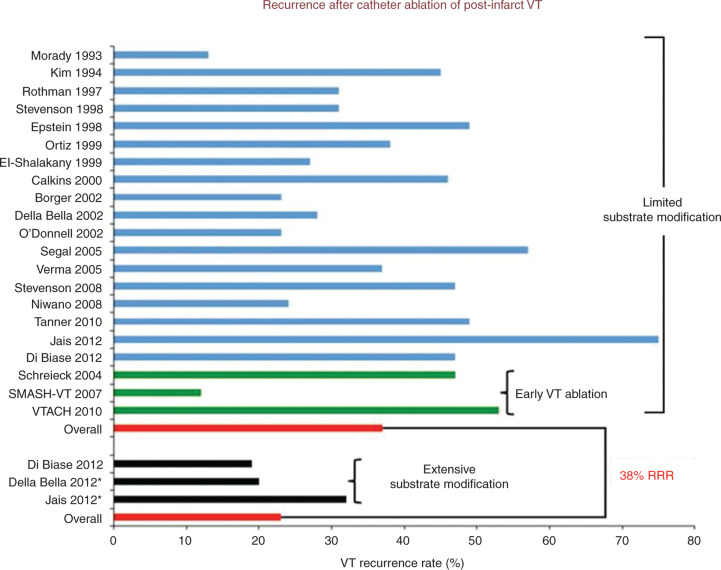
Recurrence of post-infarction VT after catheter ablation. The blue bars represent studies that used a limited substrate ablation approach. The green bars represent studies that evaluated early intervention with a limited substrate ablation. The black bars represent studies utilizing an extensive substrate-based modification ablation approach. The pooled data are depicted as red bars. *Studies that included a subgroup of patients with NICM. RRR: relative risk reduction; VT: ventricular tachycardia. Adapted from Al-Ahmad AA, Callans DJ, Hsia HH, et al. Hands-On Ablation: The Experts’ Approach. 2nd ed. Minneapolis, MN: Cardiotext Publishing, LLC; 2017. Used with permission from Cardiotext Publishing.